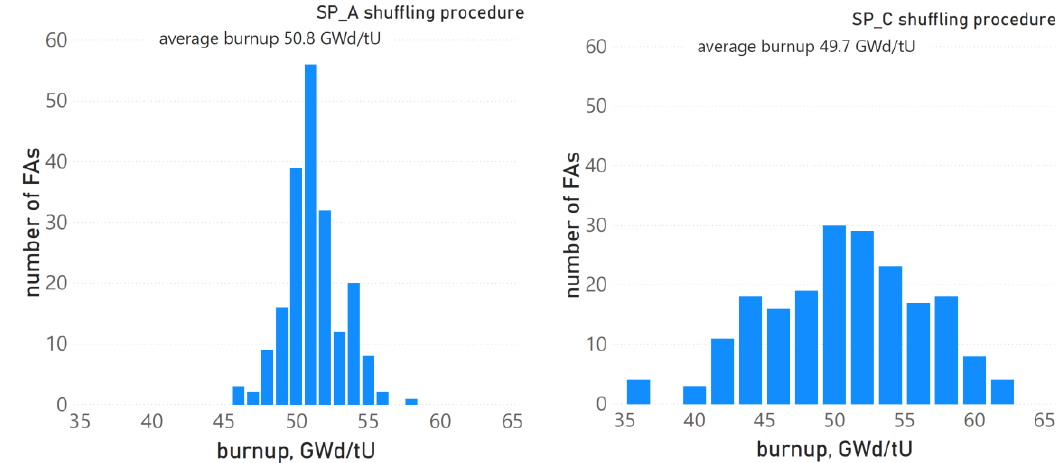
Figure 6. Discharged burnup distributions of two di ff erent shu ffl ing procedures based on the reference core map.